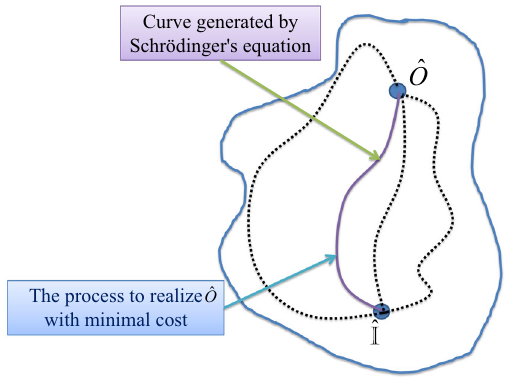
Fig. 7 The schematic figure showing the curve of a time evolution operator ˆ U ( t ) .Toreachthesametargetoperatorat t = t 0 ,therearemany different curves. The curve given by Schrödinger’s equation coincides with the curve of